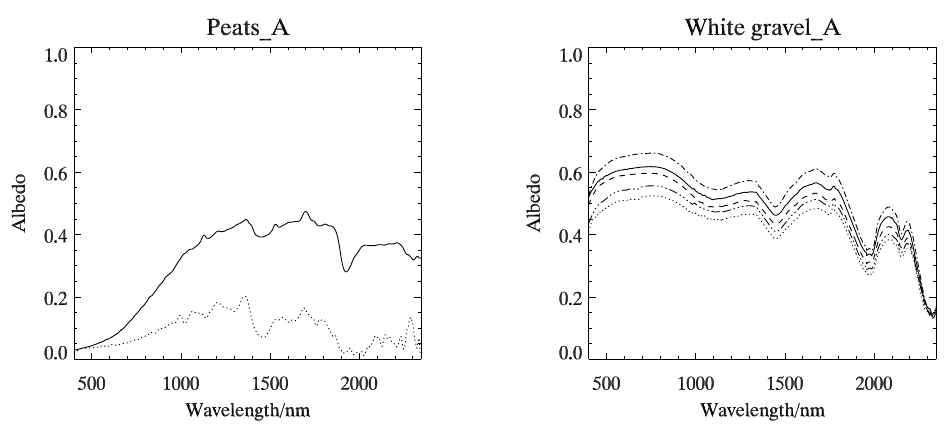
Figure 7. Left: Differences between the single peat sample from Suonenjoki when wet (dotted curve) and dry (solid line). Right: albedo of a Sjökulla white gravel sample measured in different weather, cleanness, and ageing conditions. The angle of incidence was 60 ◦ ± 5 ◦ .